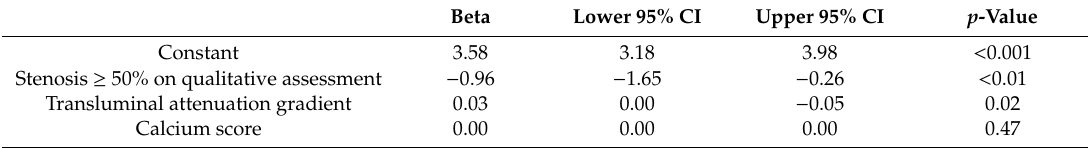
Table 4. Association between myocardial flow reserve (MFR) and variables. Multivariate analysis.